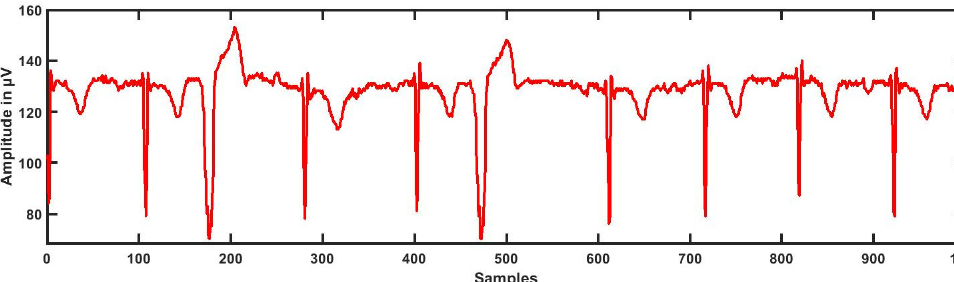
Figure 1. Typical low-risk hypertension (LRHT) ECG signal.